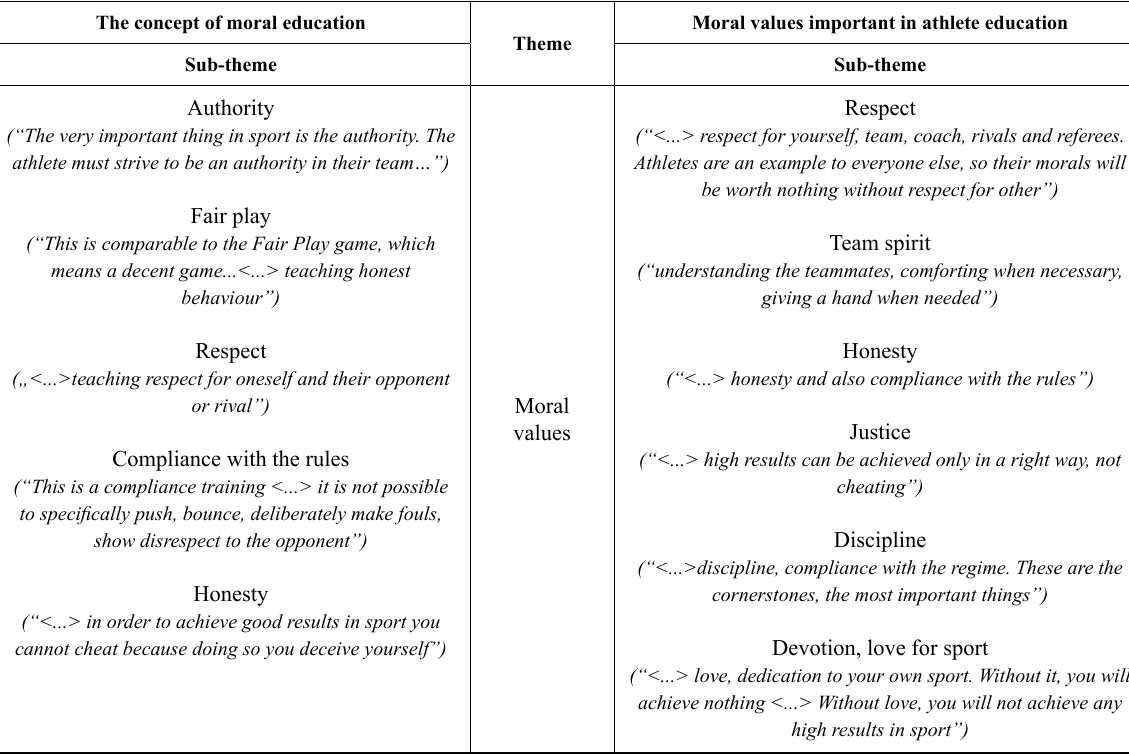
Table 2. The concept of moral education in coaches’ perspectives